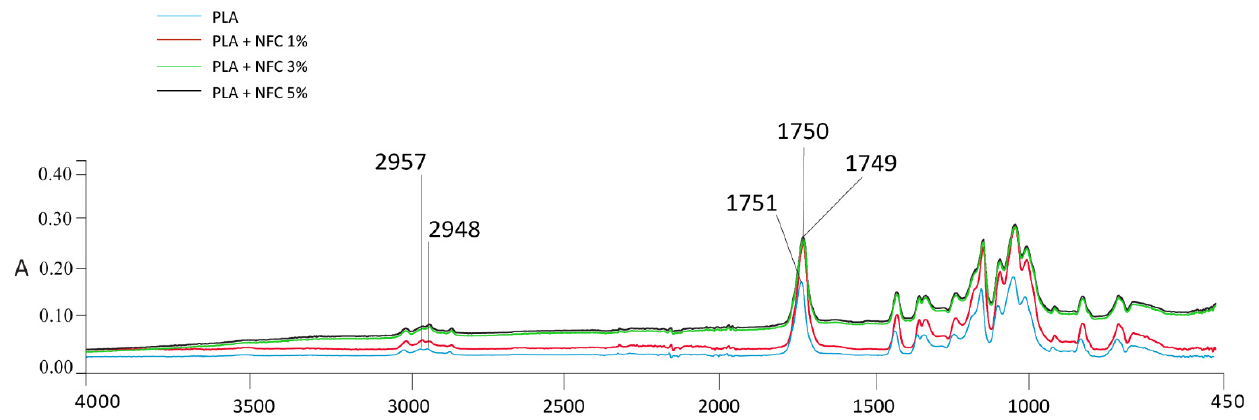
Figure 4. FTIR spectra of PLA + NFC 5%, PLA + (NFC + L) 5%, and PLA + (NFC + PL) 5% at wavenumbers of 4000–450 cm − 1 .